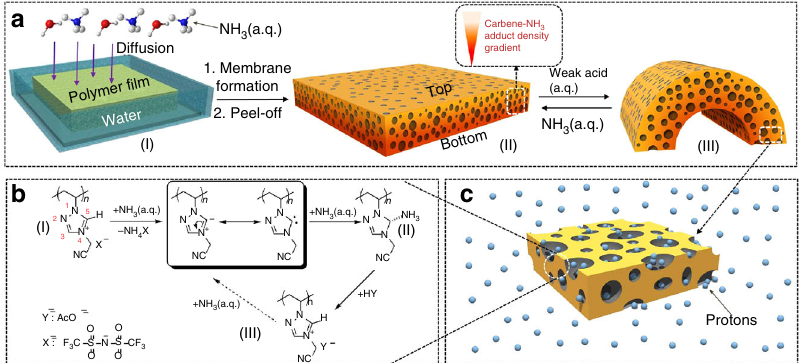
Fig. 1 Schematic diagram of the design concept and the proposed chemical structure evolution of the polycarbene-bearing nanoporous Patriaz-TA membrane actuator. a A physical blend fi lm of a Patriaz-TA mixture after aqueous NH 3 treatment, leads to electrostatic complexation (EC) between the 1,2,4-triazolium cations on Ptriaz and the carboxylate anions on TA; Note that a part of 1,2,4-triazolium cations were deprotonated by reacted with NH 3 to form carbene-NH 3 adduct (CNA) unit. A decreasing density in CNA was formed, from the membrane top to the bottom. The membrane can respond to external weak acid with bottom part inwards and restore its initial 1,2,4-triazolium state in the presence of weak base (a.q. NH 3 ). b The chemistry of reversible formation-decomposition of CNA in poly(1,2,4-triazolium) chains guides membrane actuator for ultrasensitive proton sensing in aqueous solution in